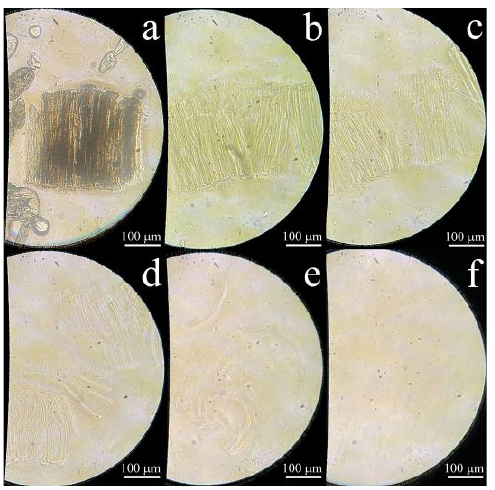
Figure 6. Dissolution of shives in NMMO, after 10 ( a ), 140 ( b ), 200 ( c ), 270 ( d ), 320 ( e ) and 540 ( f ) sec, T = 120 °C.